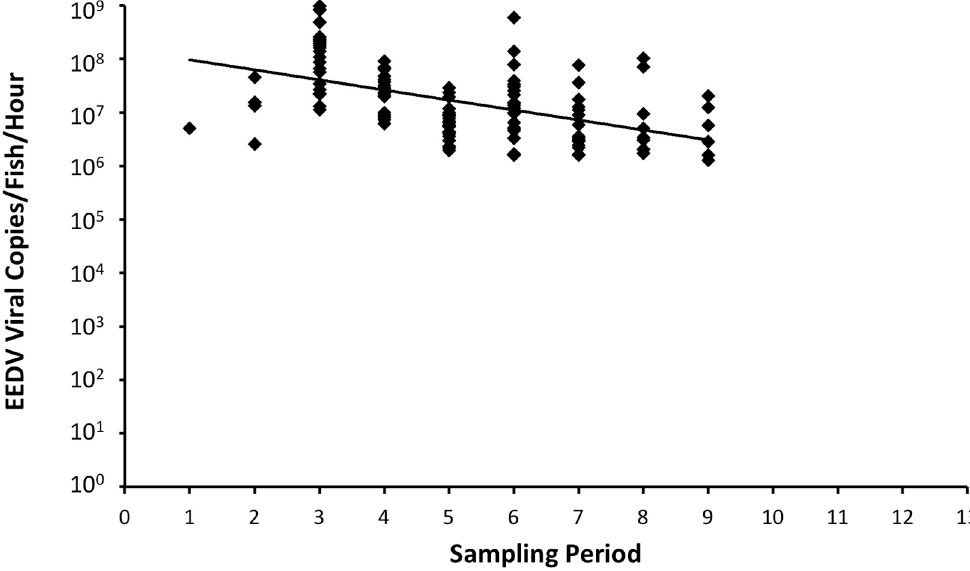
Figure 3. Shedding rate of lake trout ( Salvelinus namaycush ) in the Epizootic Epitheliotropic Disease